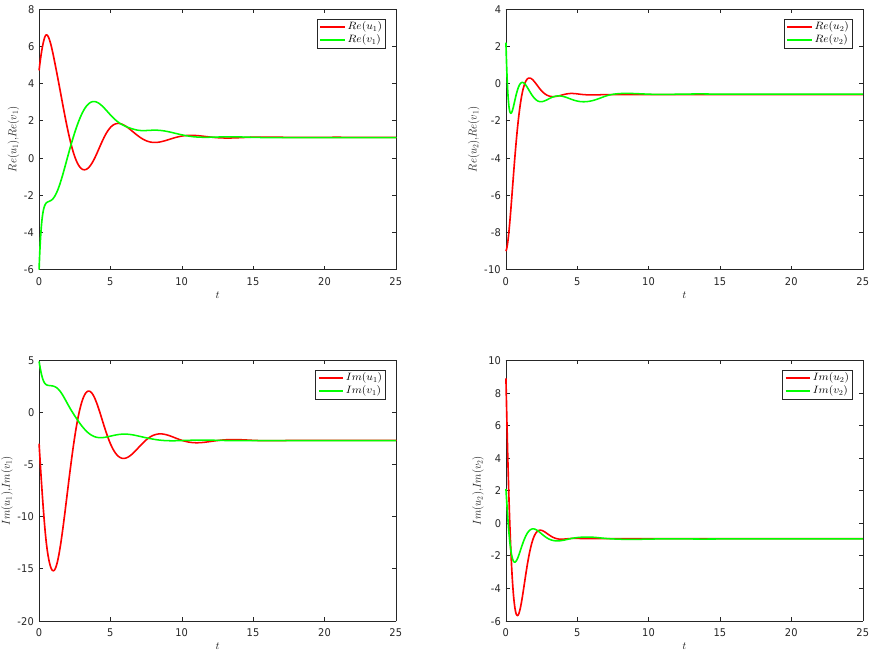
Figure 2. The curves of state u ( t ) and its estimation v ( t ) in Example 1.